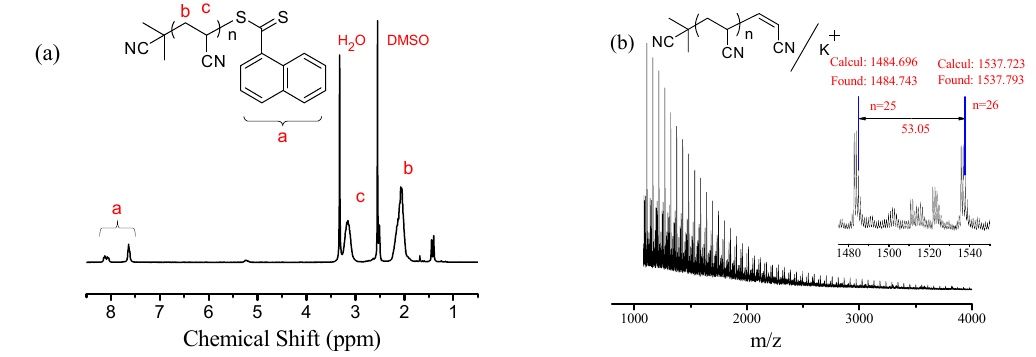
Figure 2. 1 H NMR spectrum ( a ) of PAN ( M n,GPC = 5200 g·mol − 1 , M w / M n = 1.09) and MALDI-TOF MS ( b ) of PAN ( M n,GPC = 7000 g·mol − 1 , M w / M n = 1.08) synthesized by photoinduced RAFT polymerization under blue LED irradiation.